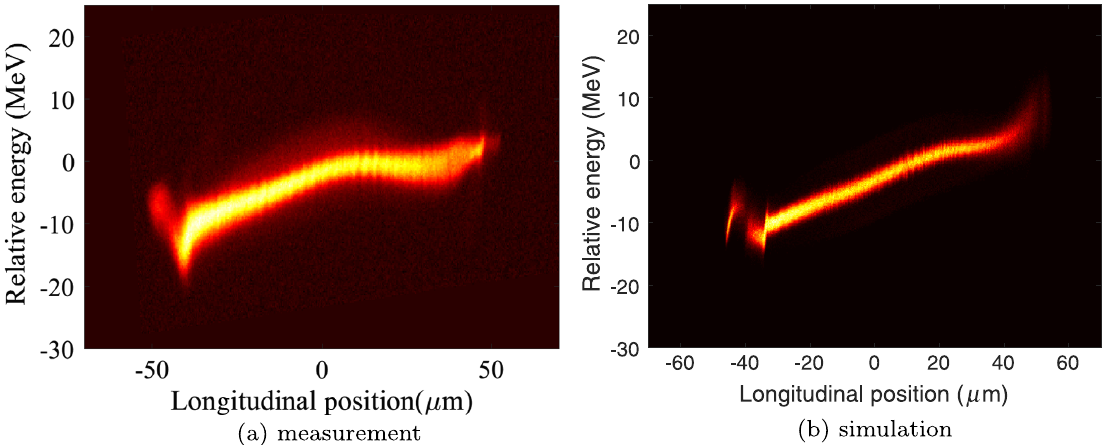
FIG. 11. Measurement (left) and simulation (right) of the final longitudinal phase space distribution with the laser heater at 19 keV. Beam current is 500 A, bunch charge 180 pC. The bunch head is to the right.